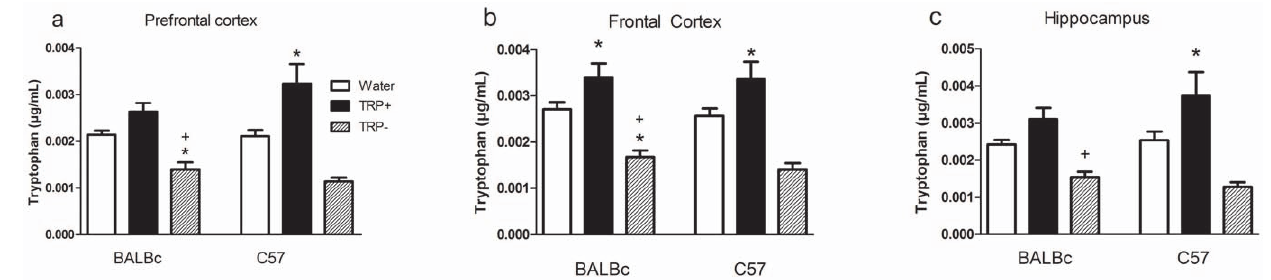
Figure 2. Brain tryptophan. Brain tryptophan content in m g/mg tissue (a) prefrontal cortex (b) frontal cortex and (c) hippocampus. BALBc and C57 mice received two treatments by gavage of TRP + , TRP 2 mixtures or water vehicle at 30 minute intervals followed by saline or NSD 1015 to inhibit amion acid decarboxylase at 2 hours. Animals were killed 2.5 hours after the first treatment. Data are collapsed for NSD treatment as no significant effects were predicted or observed. N=11–12/group. * different from Water. + different from TRP + , ¤ different from corresponding group in BALBc mice. TRP + and TRP 2 effectively raised and lowered TRP respectively, although the depletion condition was more consistently effective than the control condition. Similar effects were detected in both strains.